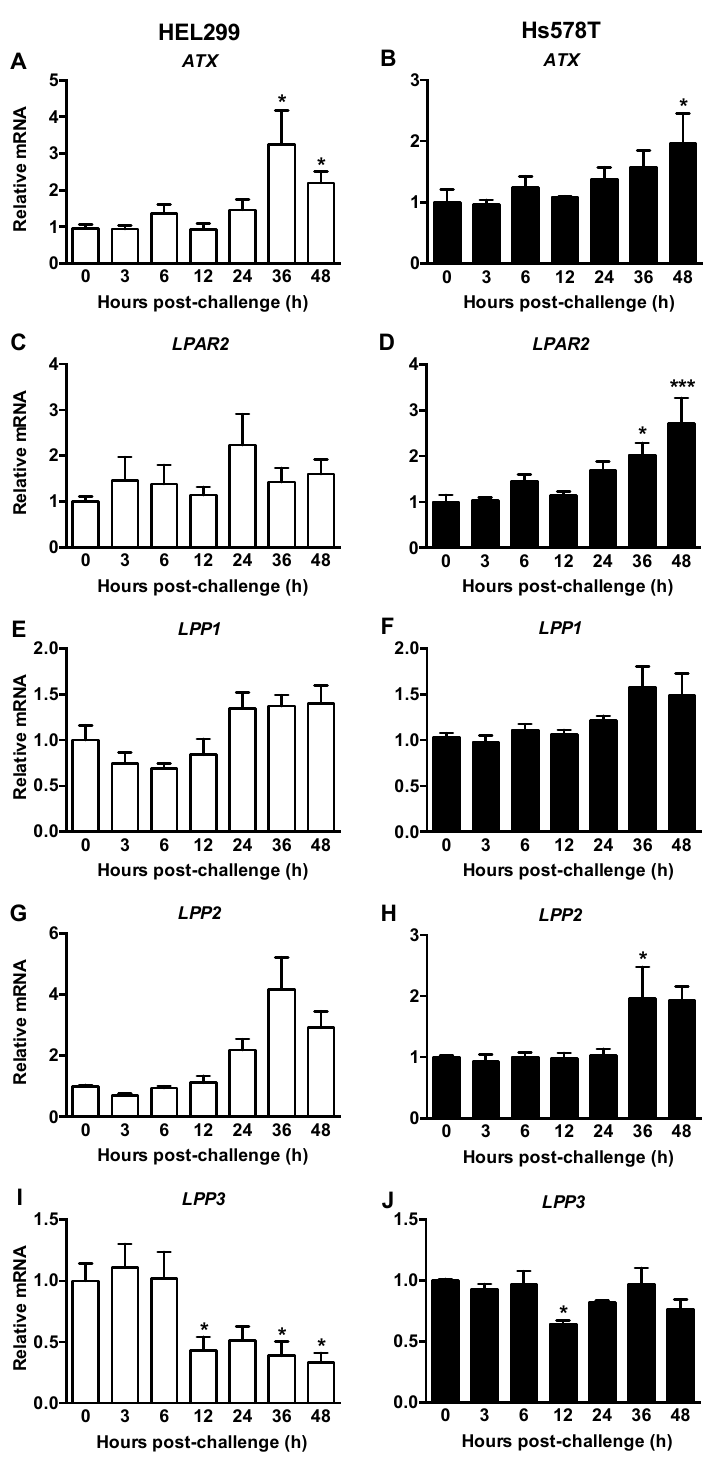
Figure 7. Exposure of HEL299 fibroblasts and Hs578T breast cancer cells to HCMV changed mRNA expression of genes involved in ATX/LPA signaling. HEL299 fibroblasts ( A , C , E , G , I ) and Hs578T breast cancer cells ( B , D , F , H , J ) were exposed to 1 or 2 MOI of HCMV, respectively. Lysates were collected and mRNAs were measured. Results are expressed relative to cells treated with a filtered control at each timepoint, and then normalized to 0 h. Results are means ± SEM from five independent experiments. P ‐ values were calculated by the nonparametric Kruskal ‐ Wallis test with a Dunn’s multiple comparisons test ( A , G ) or by one ‐ way ANOVA if the analyses passed the Brown Forsythe test ( B – F , H – J ). *, P < 0.05; ***, P < 0.001. Expression of mRNA for the LPA 2 receptor ( LPAR2 ) did not change in HCMV ‐